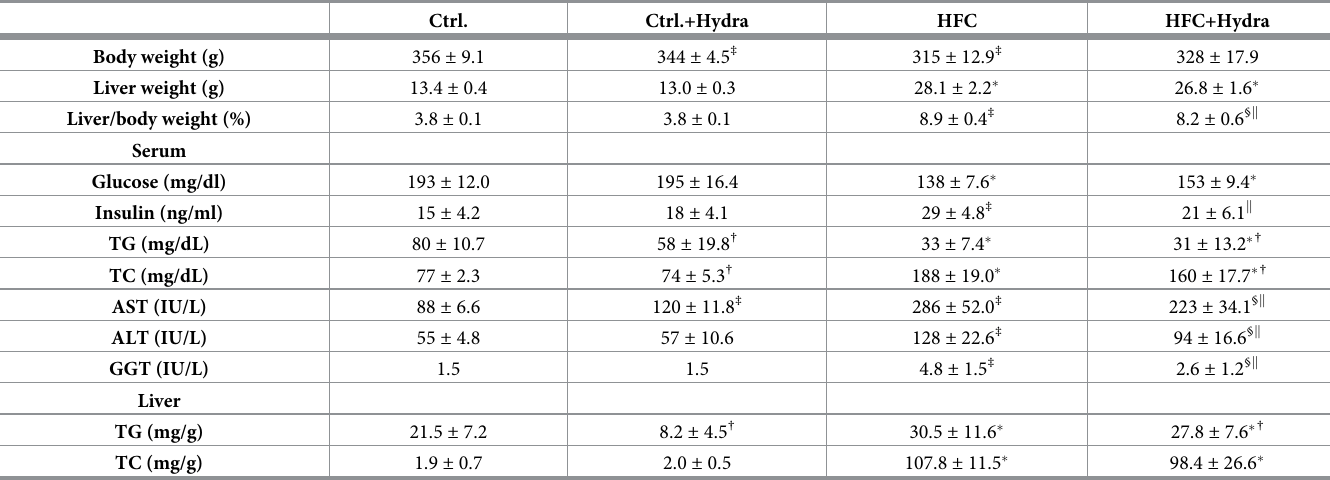
Table 1. The effects of hydralazine on body and liver weights as well as the levels of various biochemical indices in serum and liver. Ctrl.